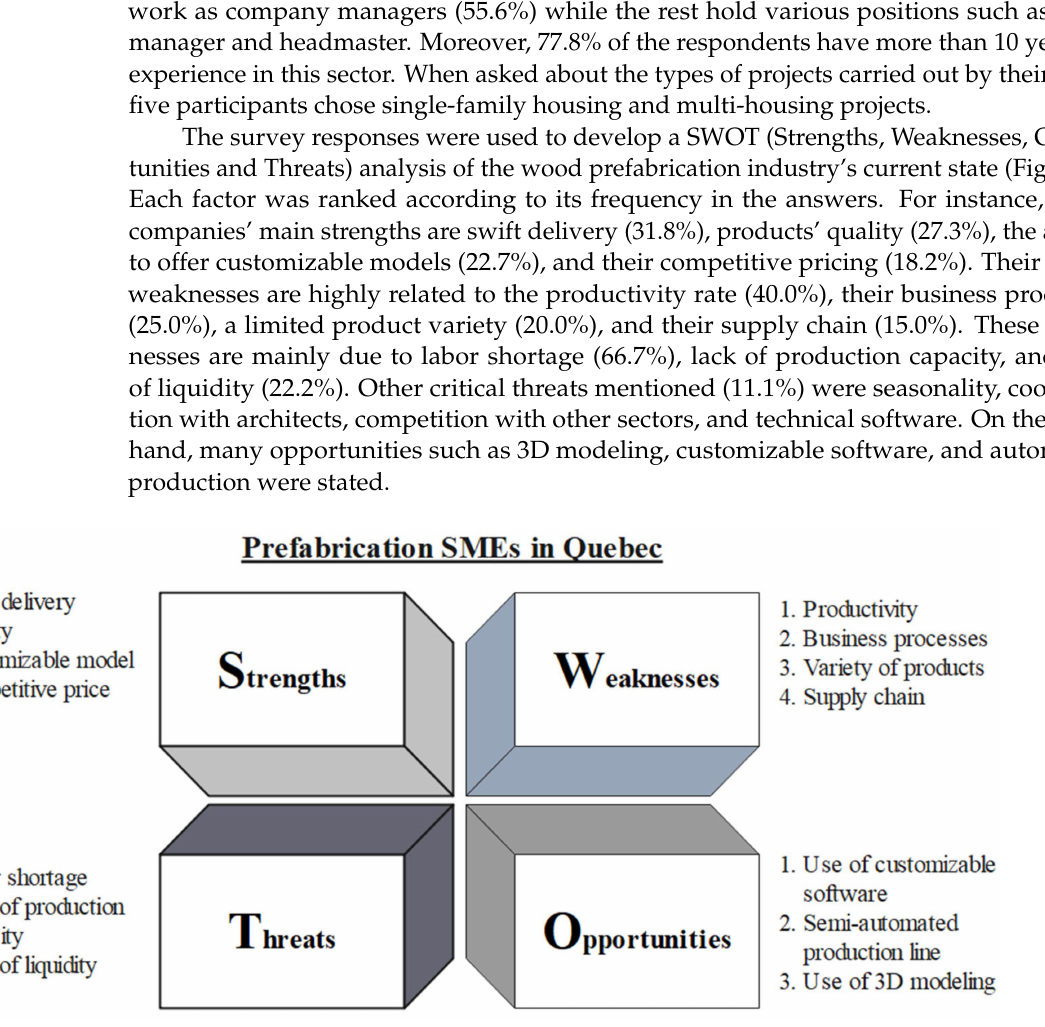
Figure 4. Survey-based SWOT analysis of prefabricated